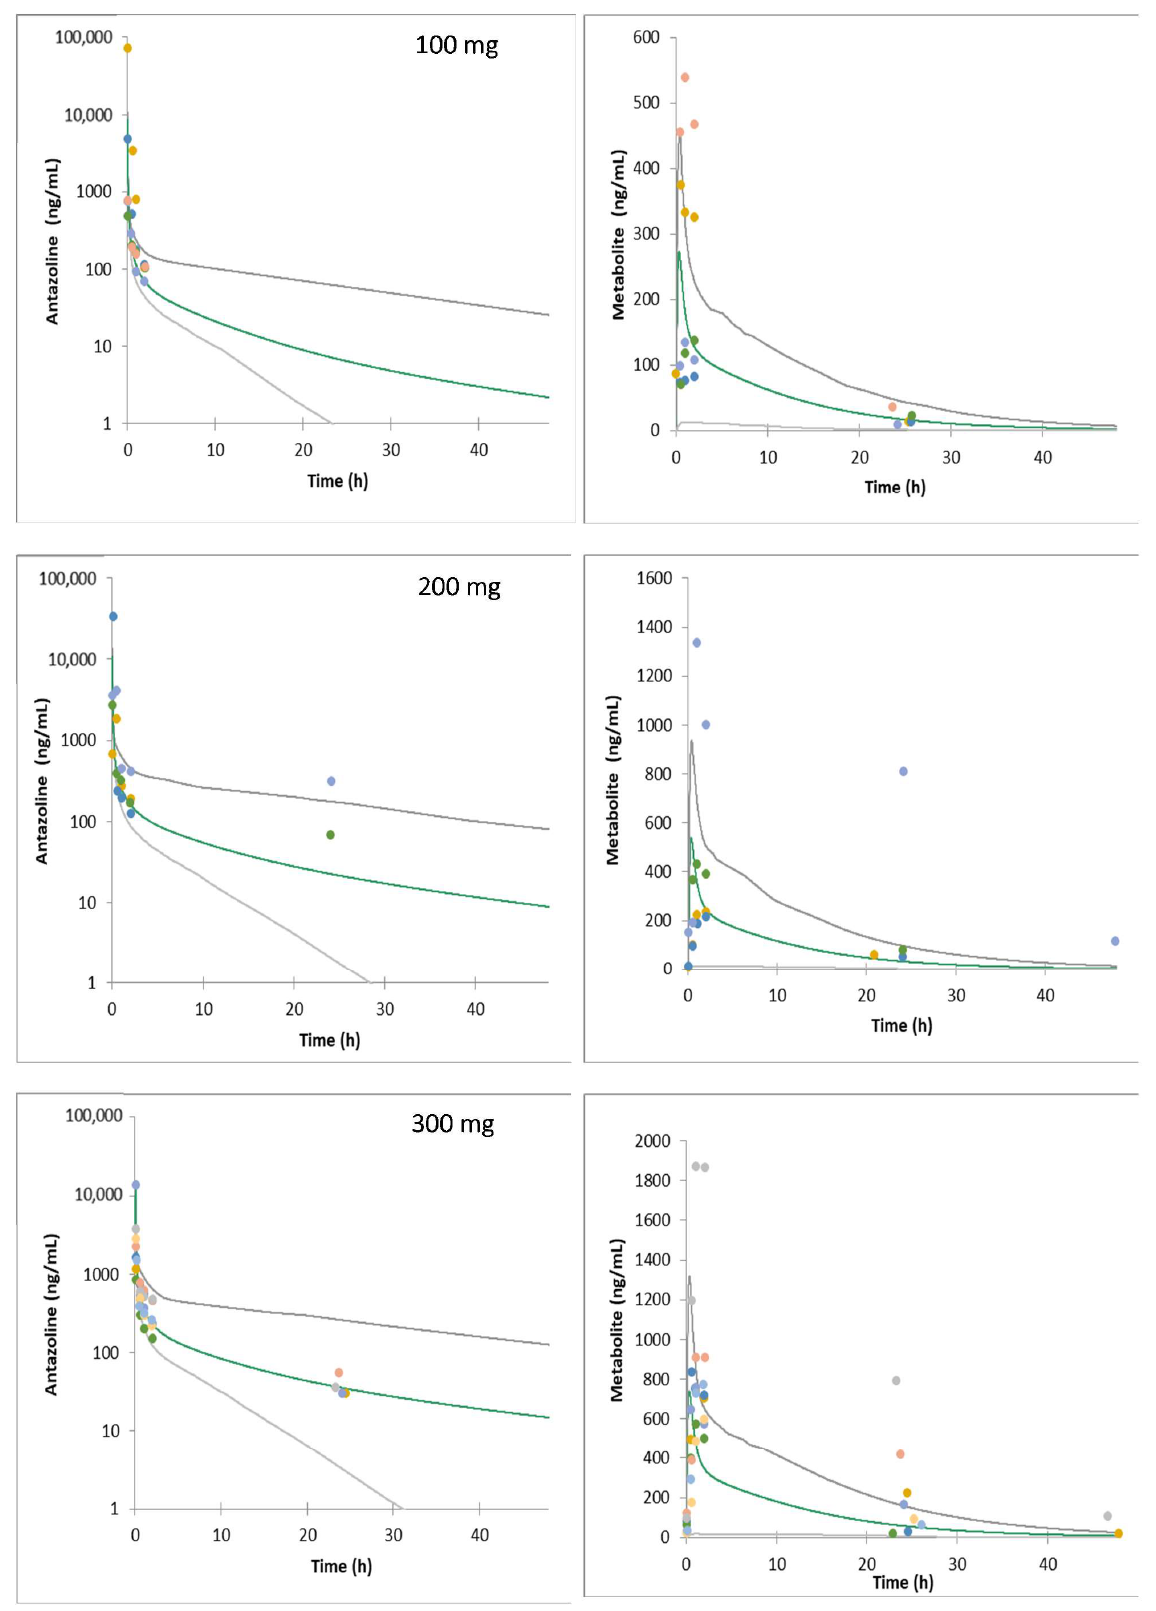
Figure 3. Mean simulated systemic plasma concentrations profiles of antazoline and its metabolite following 100, 200, and 300 mg antazoline infusion (patients, ELEPHANT III study). Dots—observed individual data; gray lines—5th and 95th percentile; green line—simulated average